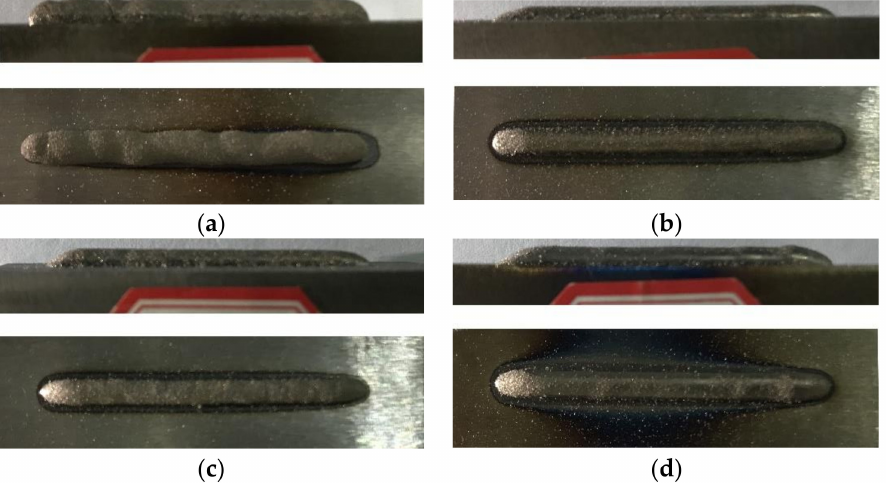
Figure 4. Macroscopic morphology of the specimens. ( a ) No. 1; ( b ) No. 2; ( c ) No. 3; ( d ) No.